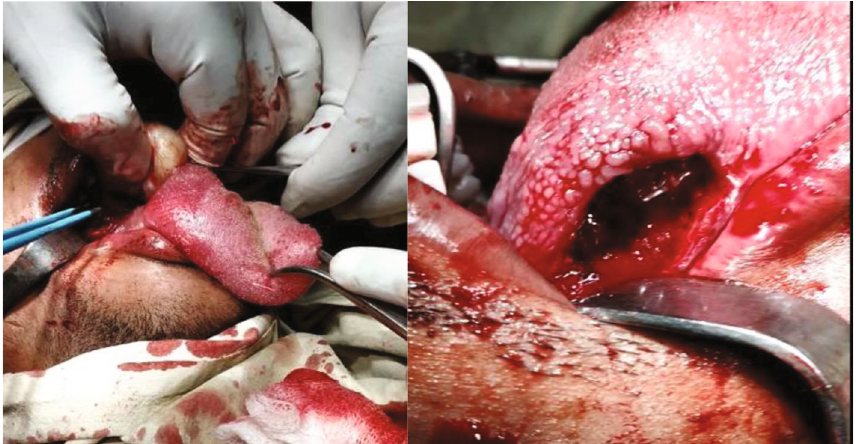
Figure 5: Surgical fi eld after removal of the tumour.